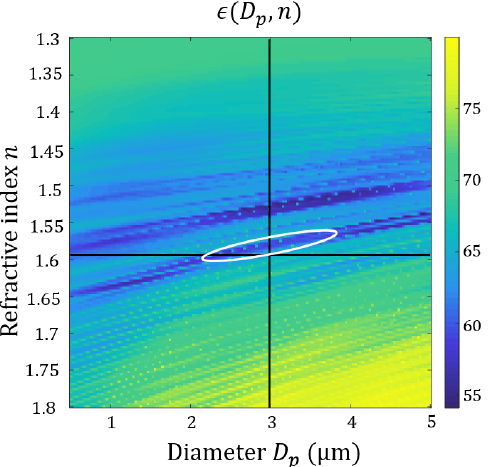
Figure 15a. The minimization criterion is plotted in Figure 17 as a function of 𝐷 (cid:3043) and 𝑛 .